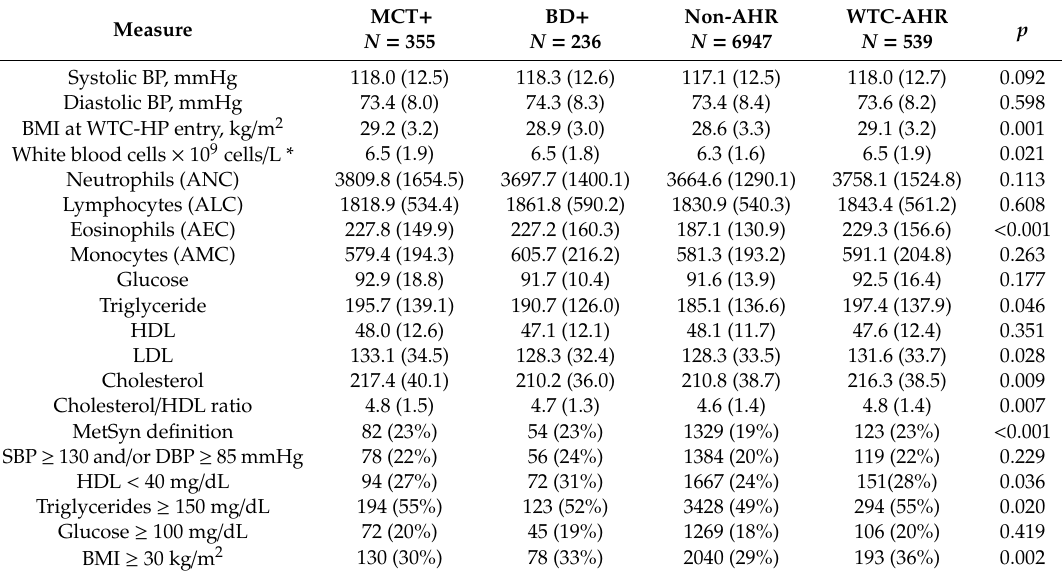
Table 2. Clinical measures of inflammation and metabolic